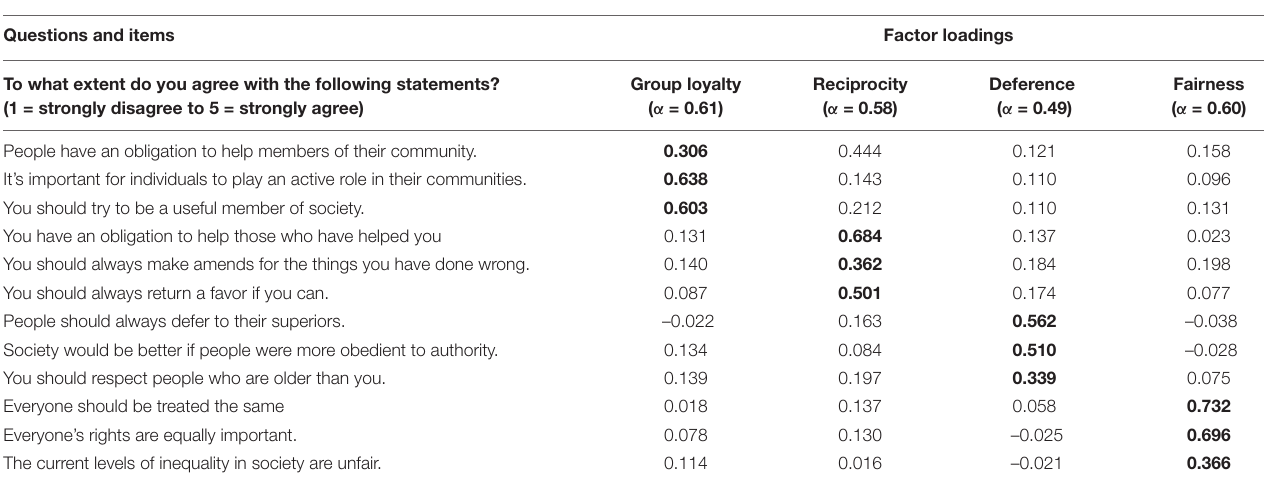
TABLE 6 | Rotated factor matrix of